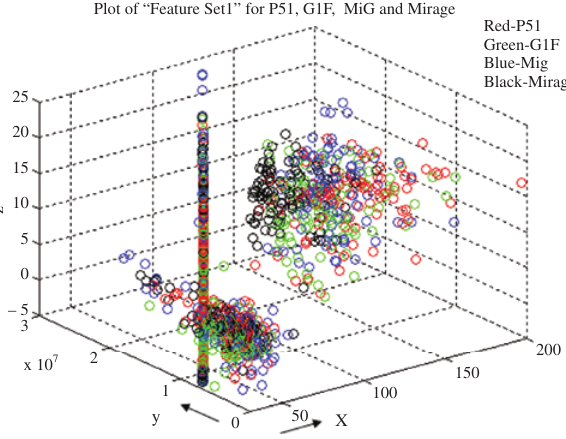
Figure 5: Plot of FS1 for the P51, G1F, MiG, and Mirage Aircraft Models.